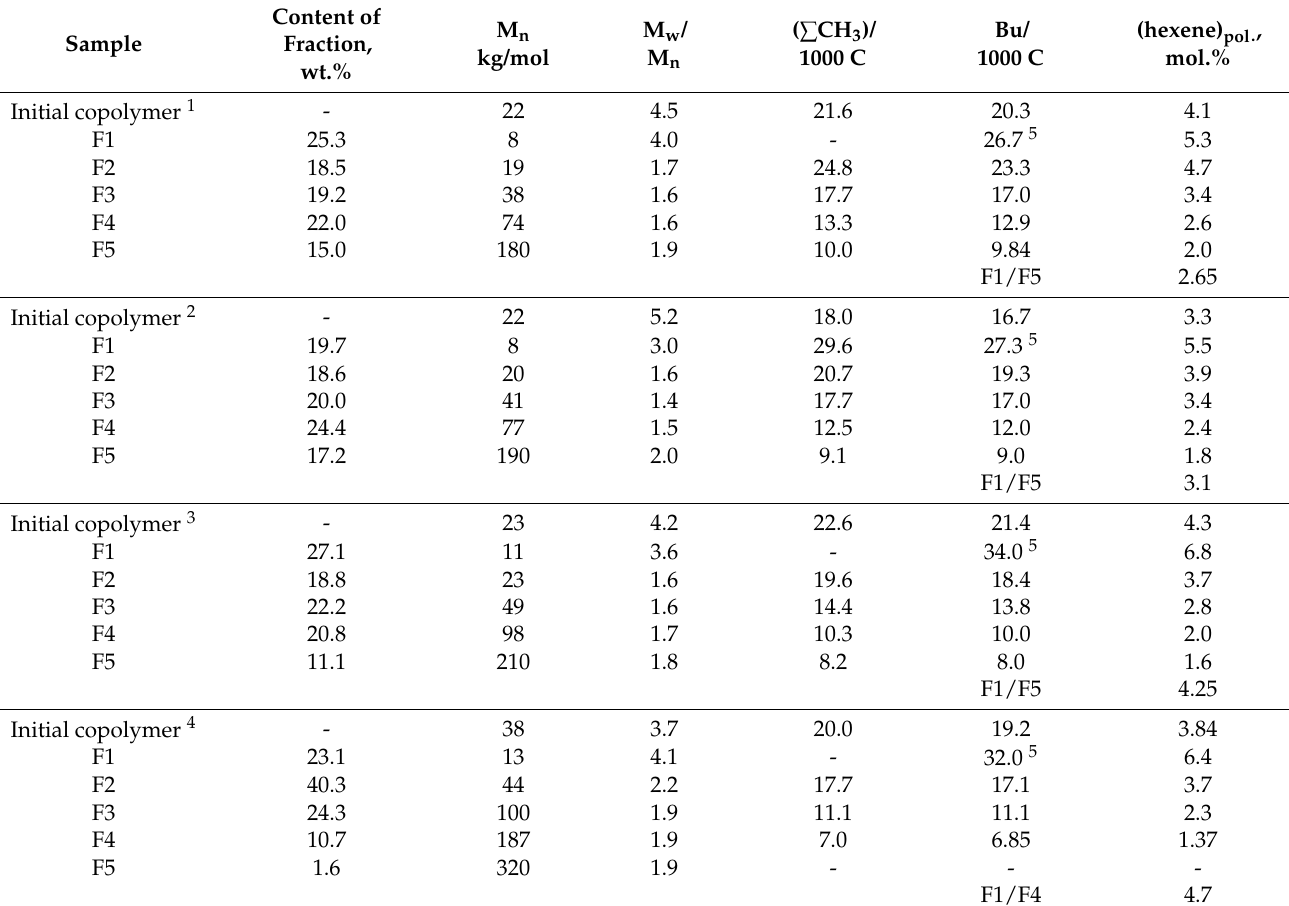
Table 3. Data on the molecular weight characteristics of individual fractions and the content of branch- ings in these fractions for copolymers produced over TMC-1, TMC-1-2, TMC-2, and TMC-3